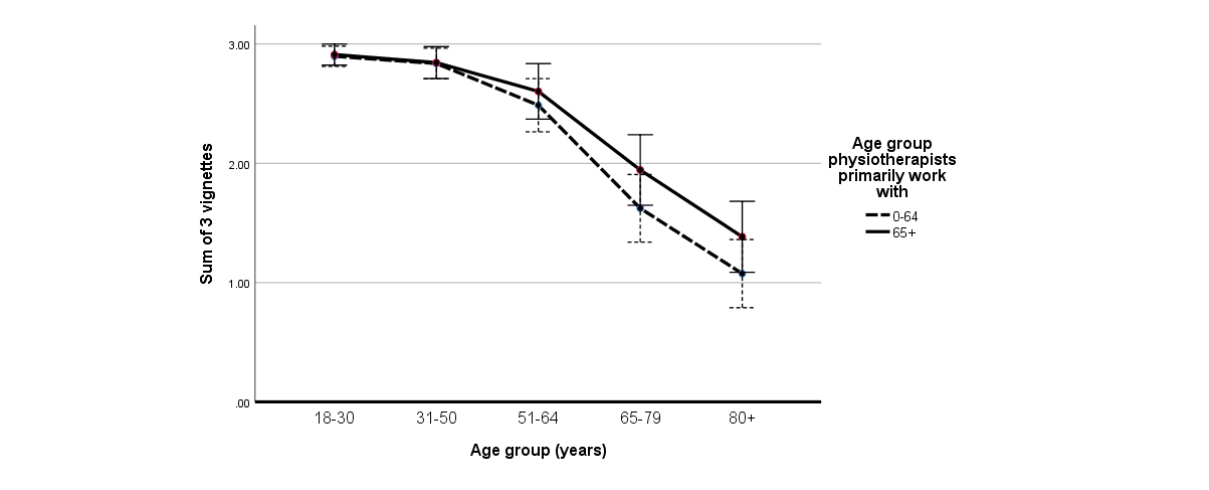
Figure 2. Assessed ability to use health care digital technologies by age group assessed and the primary age the physiotherapists work with (N=94). Error bars: 95%